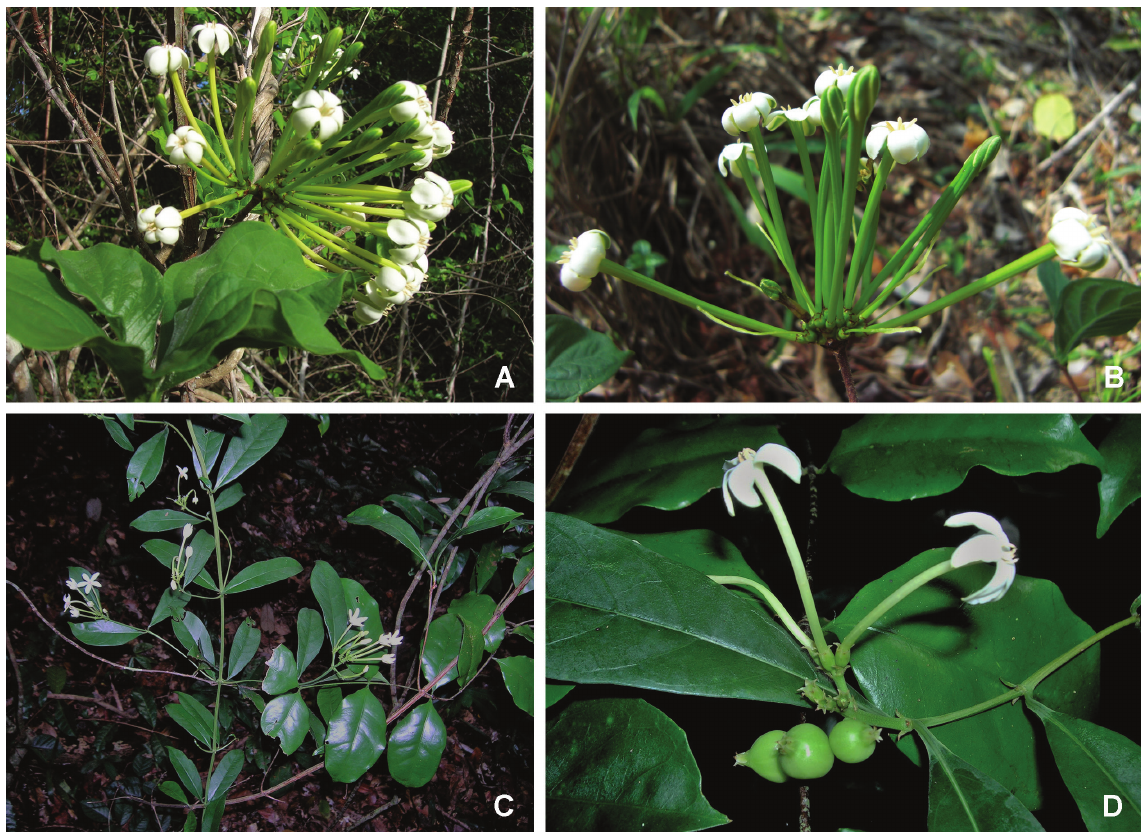
Fig. 2. Species of Cladoceras Bremek. in the field. A – B . Cladoceras rovumense I.Darbysh.,